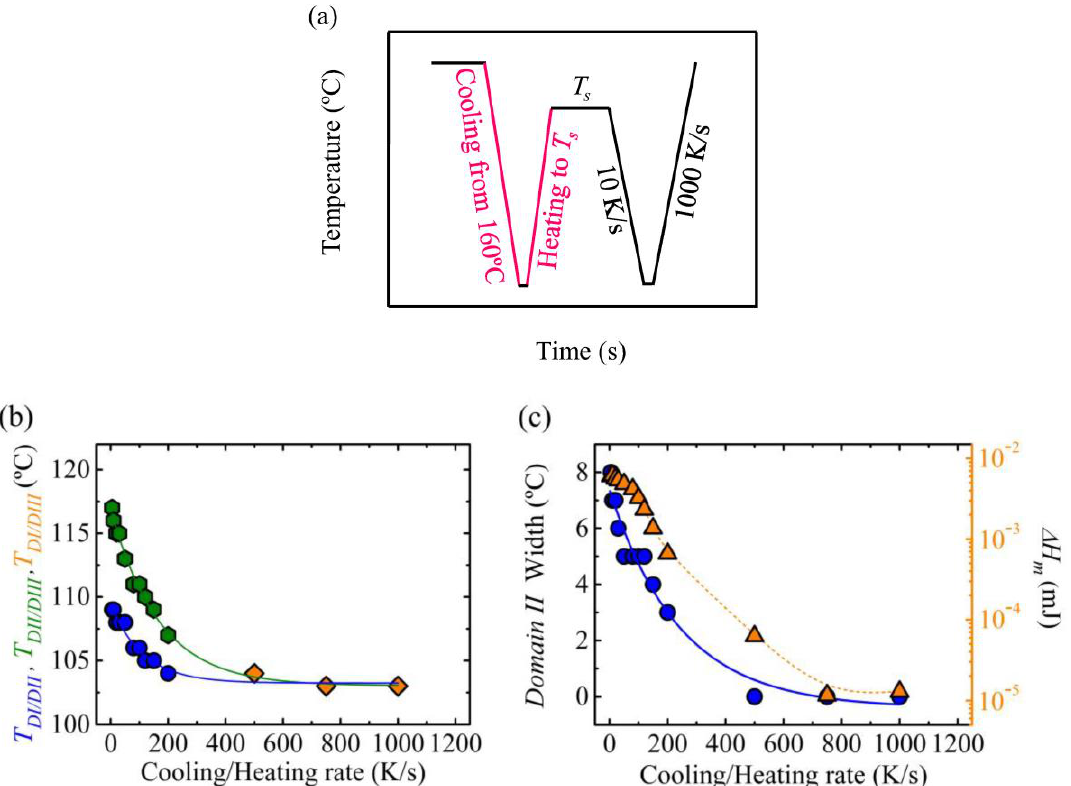
Figure 8. ( a ) Thermal procedure employed to analyze the effect of cooling rate from 160 °C and heating to T s (the same rate is employed for cooling and heating in each set of experiments), in order to erasure the thermal history the sample is kept at 160 °C for 30 s and it is cooled down to −50 °C, the sample is kept at this temperature, −50°C, for 0.1 s), the sample is kept at the T s temperature for 300 s, ( b ) transition temperature between Domains as a function of the cooling/heating rate and ( c ) width of Domain II and melting enthalpy as a function of the cooling/heating rate.